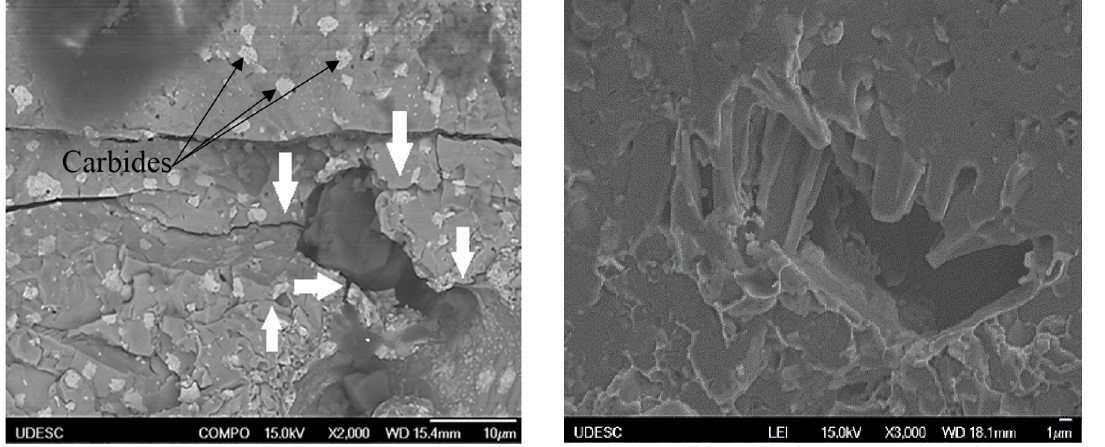
Figure 6. Crack propagation starting from the pore - BSE mode. Figure 7. Pores filling in the boride layer - SE